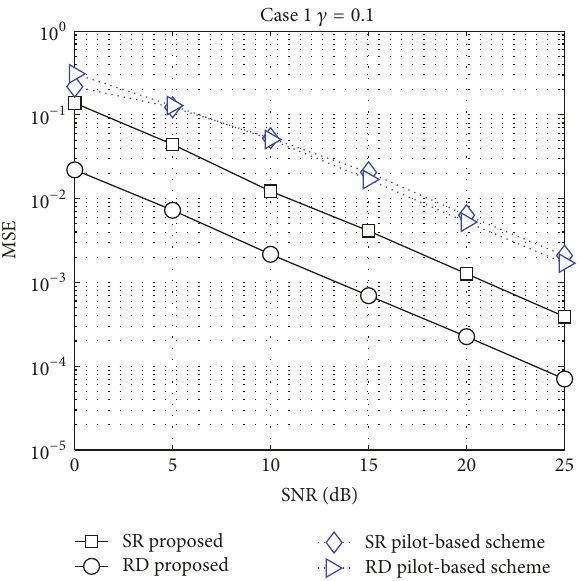
Figure 6: MSE performance with different schemes for Case 1